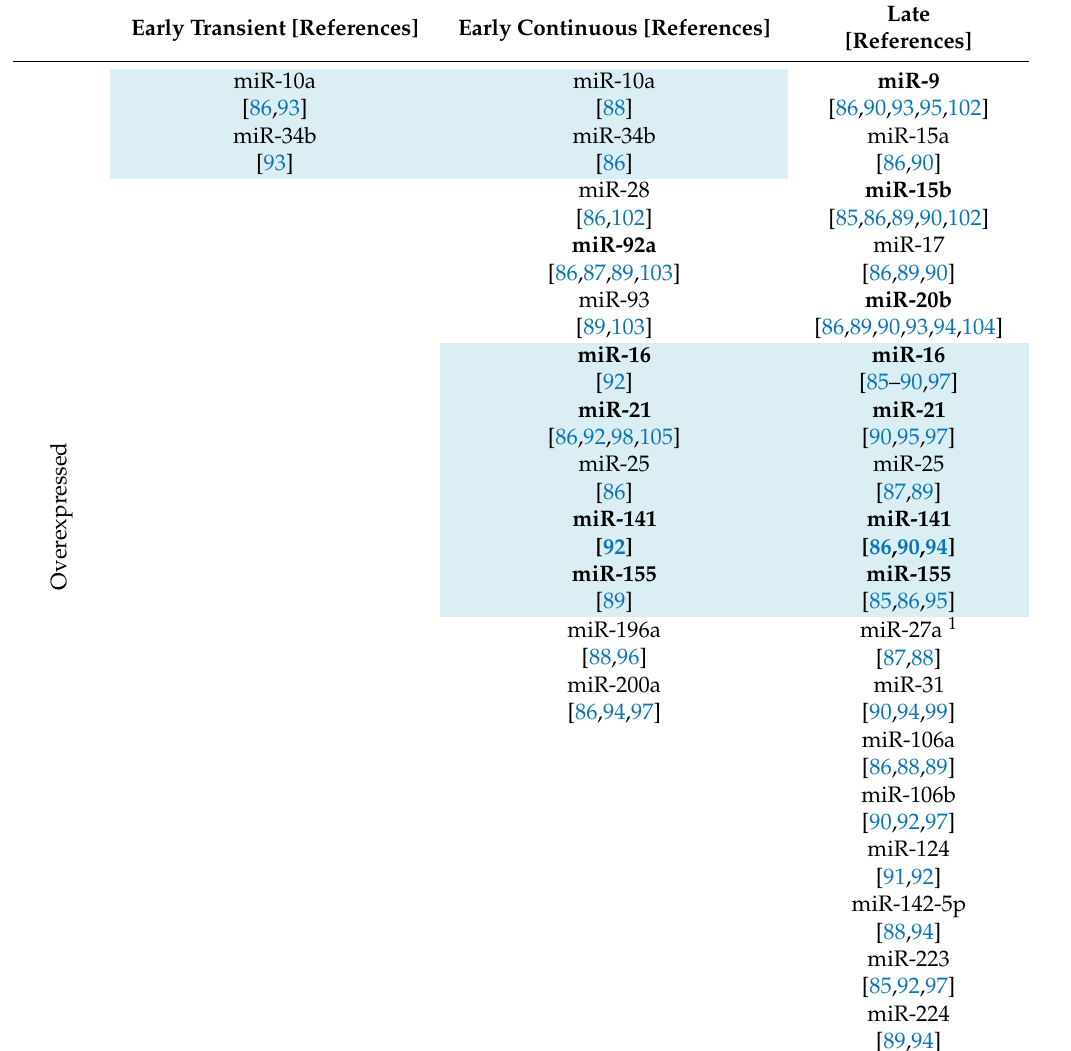
Table 1. Dynamics of microRNA (miRNA) expression revealed in cervical biopsies or exfoliative